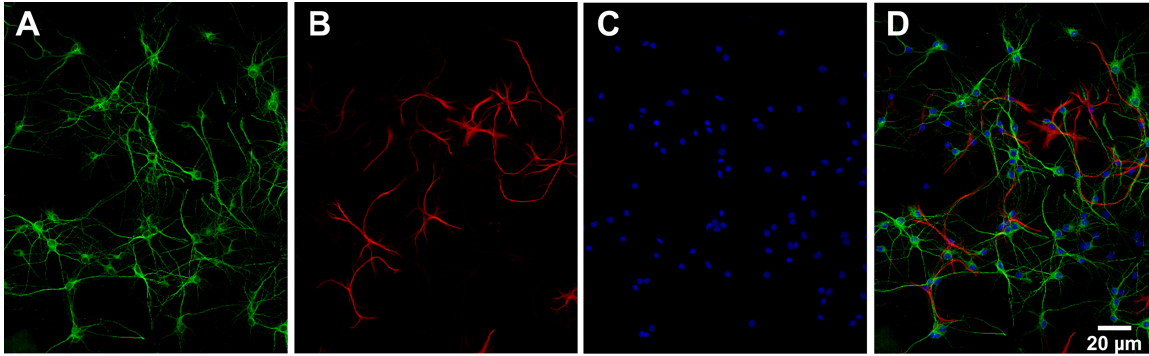
Figure 3. Characterisation of primary hippocampal cell culture. Representative images of ( A ) the expression of microtubule-associated protein 2 (MAP2) shown in green, ( B ) the expression of glial fibrillary acidic protein (GFAP) shown in red and ( C ) the cell nuclei stained with 4 (cid:48) ,6-diamidino-2- phenylindole (DAPI) shown in blue in a primary hippocampal culture. ( D ) MAP2 (green), GFAP (red) and DAPI (blue) are merged. The images were acquired using ImageXpress (Molecular Devices) mounted with a 20 ×